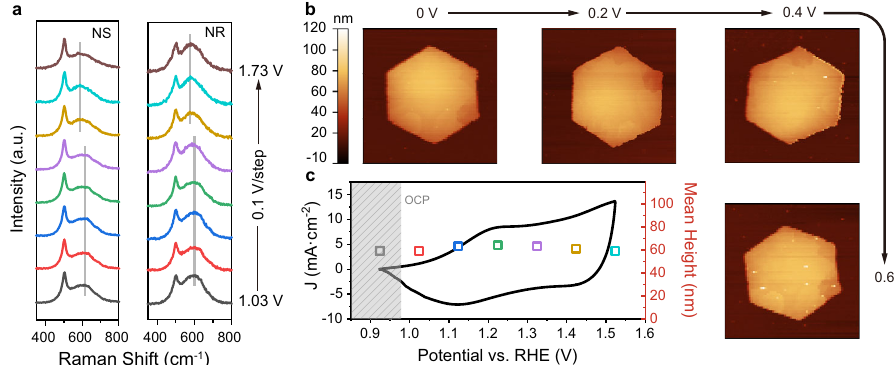
Fig. 3 | In situ Raman and EC-AFM analysis of CoOOH NS and NR. a Raman spectra under applied potentials ranging from 1.03 to 1.73V vs. RHE (from bottom to top, with the interval of 0.1V); b AFM images and c corresponding height of NS underappliedpotentialsrangingfrom1.03to1.73Vvs.RHE.ThecorrespondingCV